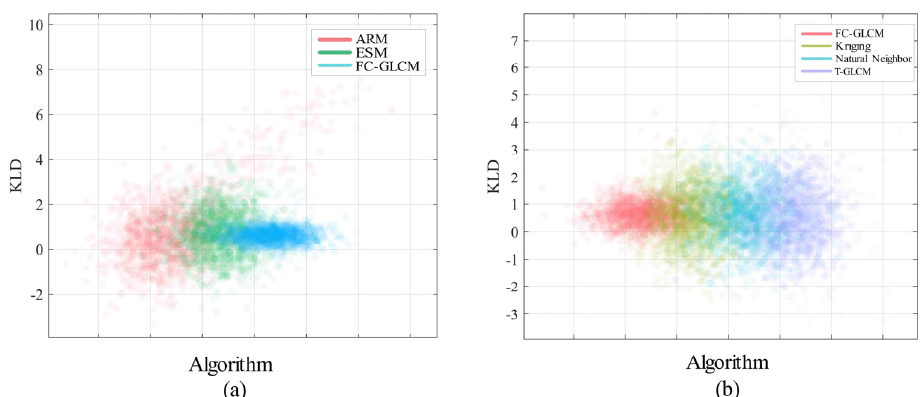
Figure 13. Comparison of KLD index between the proposed FC-GLCM and classic algorithm. ( a ) Comparison of the proposed FC-GLCM method with the ARM and ESM; ( b ) comparison of the proposed FC-GLCM method with the Kriging, natural neighbor, and T-GLCM approaches.